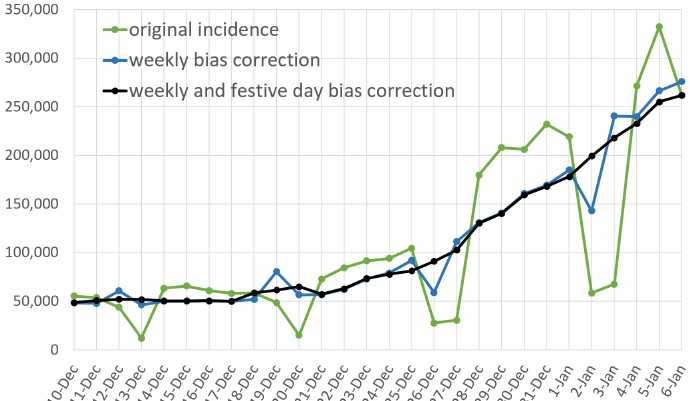
Figure 3. Incidence curve (in green) of France up to 6 January 2022. In blue, the incidence corrected of the weekly bias, in cyan the incidence corrected of the weekly and festive day. The Christmas holidays introduce a distortion in the weekly bias corrected incidence that is corrected by the festive day bias